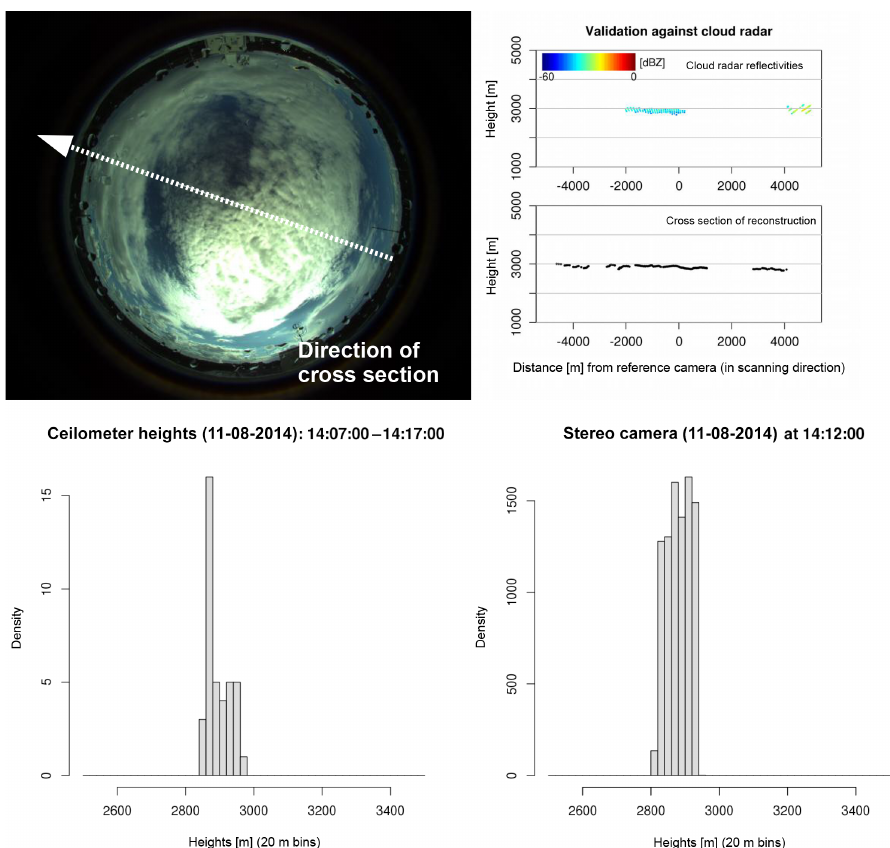
Figure 14. Comparison of the reconstruction with cloud radar (cross section) and lidar (near-zenith cloud-base heights) at 11 August 2014, 14:12:00UTC. The original fisheye image showing the respective direction of the cross sections (top left). The cross section of the re- construction compared with the reflectivities from the cloud radar (top right). Histogram of the cloud-base heights observed by the stereo camera (bottom left) and the lidar-ceilometer (bottom